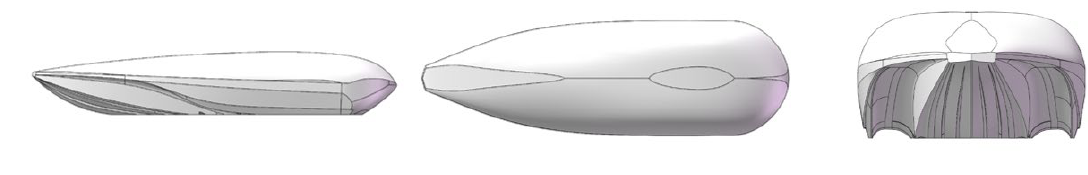
Table 2. Longitudinal position of the highest point of the